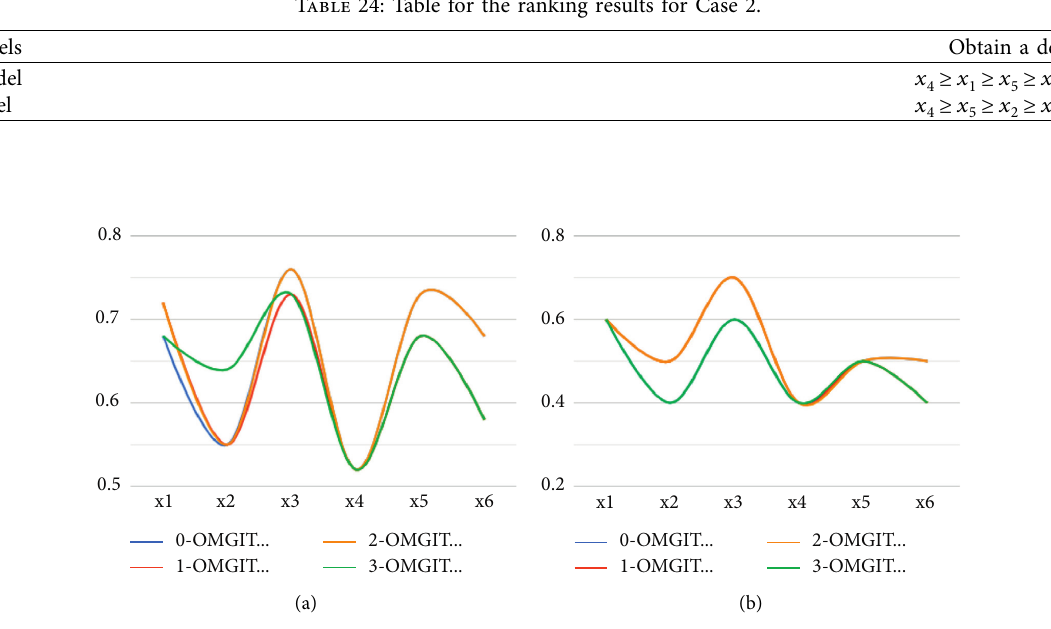
Figure 1: The representations of the lower approximations by using our model and Zhan model in two cases.